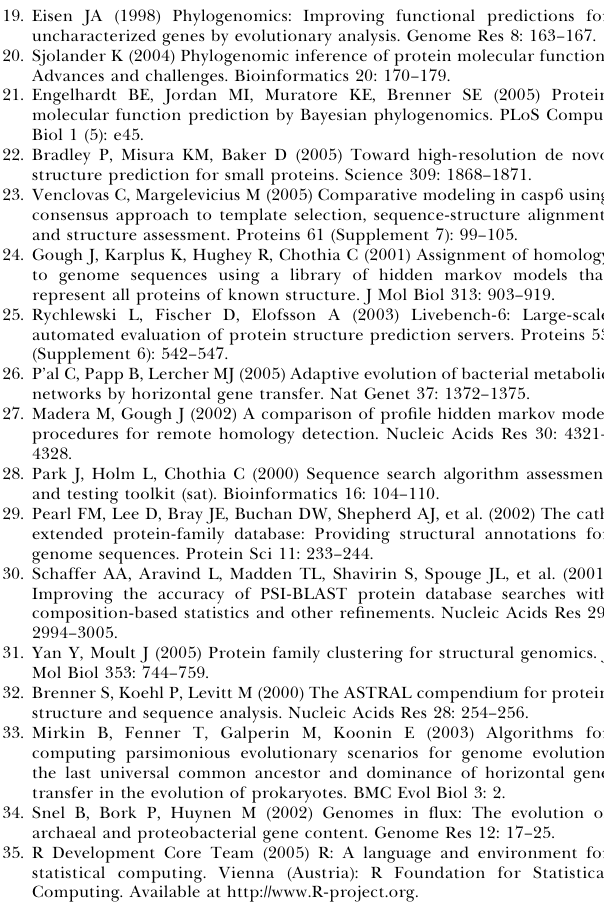
Figure S1. Correlation between e-Values and the Distance to a Source Sequence Correlation between e-values and the distance to a source sequence for both SUPERFAMILY (A) and PSI-BLAST (B). The distance to a source sequence for an occurrence is calculated as the distance to the youngest common ancestor between the occurrence and a genome containing a source sequence. The correlation shown is very weak (r- squared is 0.05 for SUPERFAMILY and 0.15 for PSI-BLAST). Found at doi:10.1371/journal.pcbi.0030003.sg001 (4.0 MB PDF). Figure S2. The Frequency of e-Values for Different Cluster Distances (A,B) Show that occurrences with a relatively high cluster distance ( . 1.01) have a distribution similar to the assignment distribution for